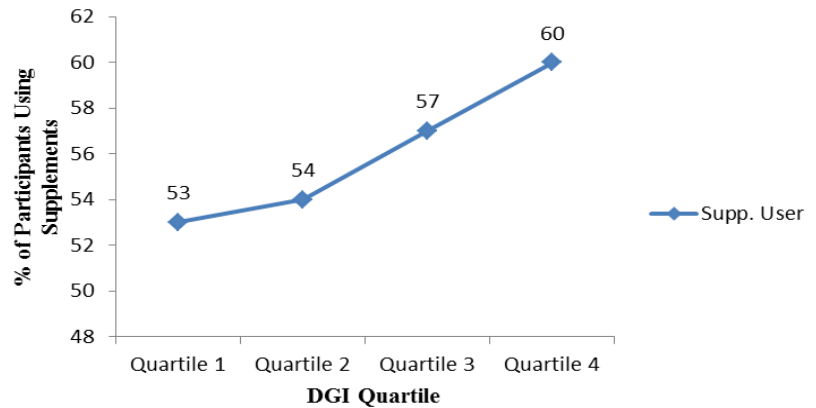
Figure 2. Percentage of supplement users per dietary guideline index (DGI) quartile ( n = 1302). p =